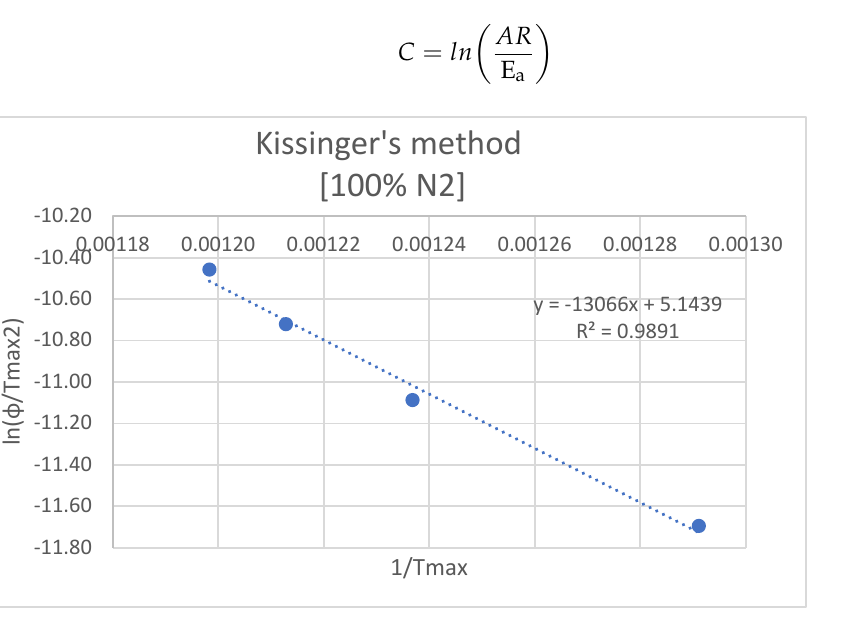
Figure 4. Kissinger’s method for thermal decomposition [own elaboration]. Table 1. Apparent activation energy during thermal